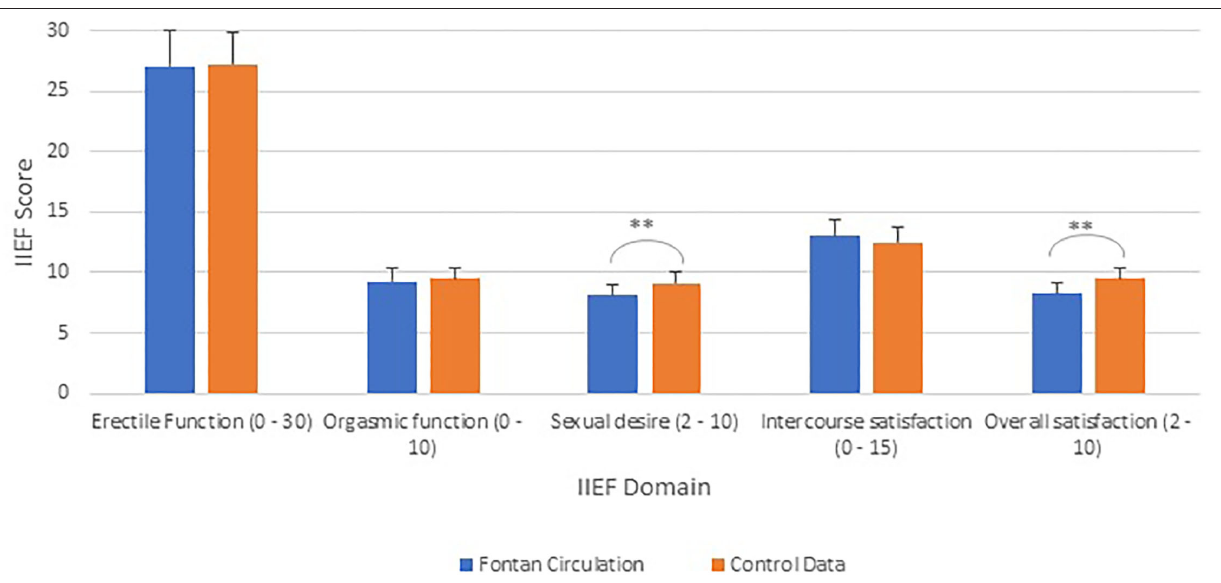
Frontiers in Pediatrics |